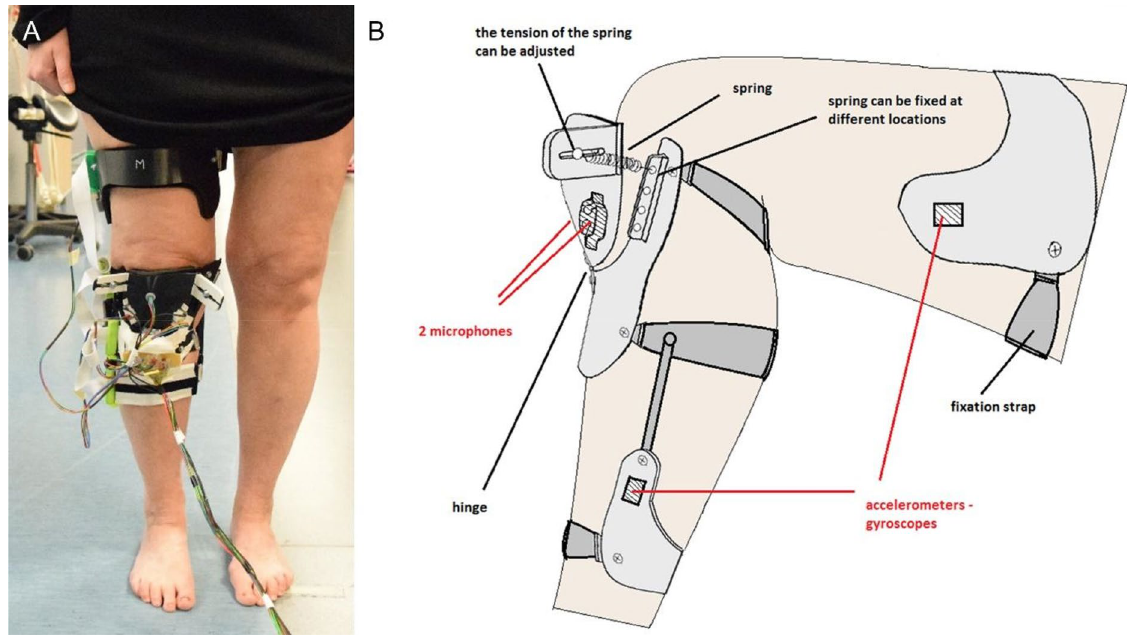
Figure 5. The apparatus used to collect the acoustic emission and kinematic signals on a test subject ( A ). The raw schematics of the device are also shown ( B